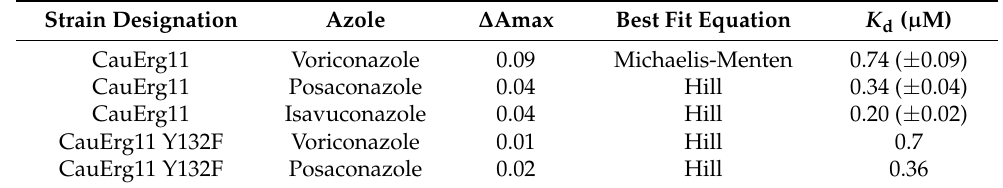
Figure 4. Binding studies with wild-type CauErg11-6 × His and CauErg11-6 × His Y132F. Type II difference spectra of 1 µ M ( a1 ) CauErg11 in the presence of VRC, POS or ISA, ( b1 ) CauErg11 Y132F in the presence of VRC or POS. Saturation curves of 1 µ M C. auris Erg11 proteins titrated against ( a2 ) 2 µ M VRC, 1.4 µ M POS, and 1.2 µ M ISA. ( b2 ) 1.8 µ M VRC and 1.2 µ M POS (all diluted in DMSO). Table 3. Type II binding of azoles to CauErg11-6 × His and CauErg11 Y132F-6 ×